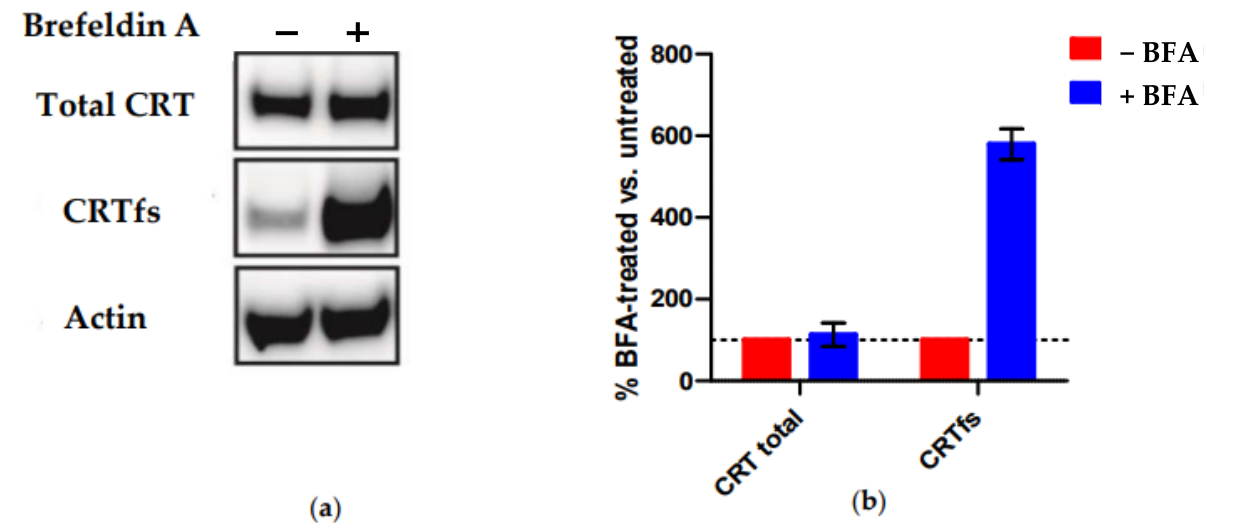
Figure 9. Reactivity of SSI-HYB 385-06 to frameshifted calreticulin (CRTfs) in MARIMO cells analysed by Western blotting. ( a ) MARIMO wells were treated with methanol ( − brefeldin A (BFA)) or with BFA, whereafter cells were lysed and examined by Western blotting under reduced conditions. The monoclonal antibody FMC-75 to calreticulin (CRT) was used to detect the total intracellular CRT level, as this antibody interacts with an epitope in the N-terminal, thus detecting wildtype and mutated CRT [37]. CRTfs was stained using SSI-HYB 385-06. Actin was used as loading control ( b ). Quantification of CRT and CRTfs levels based on Western blot in ( a ).